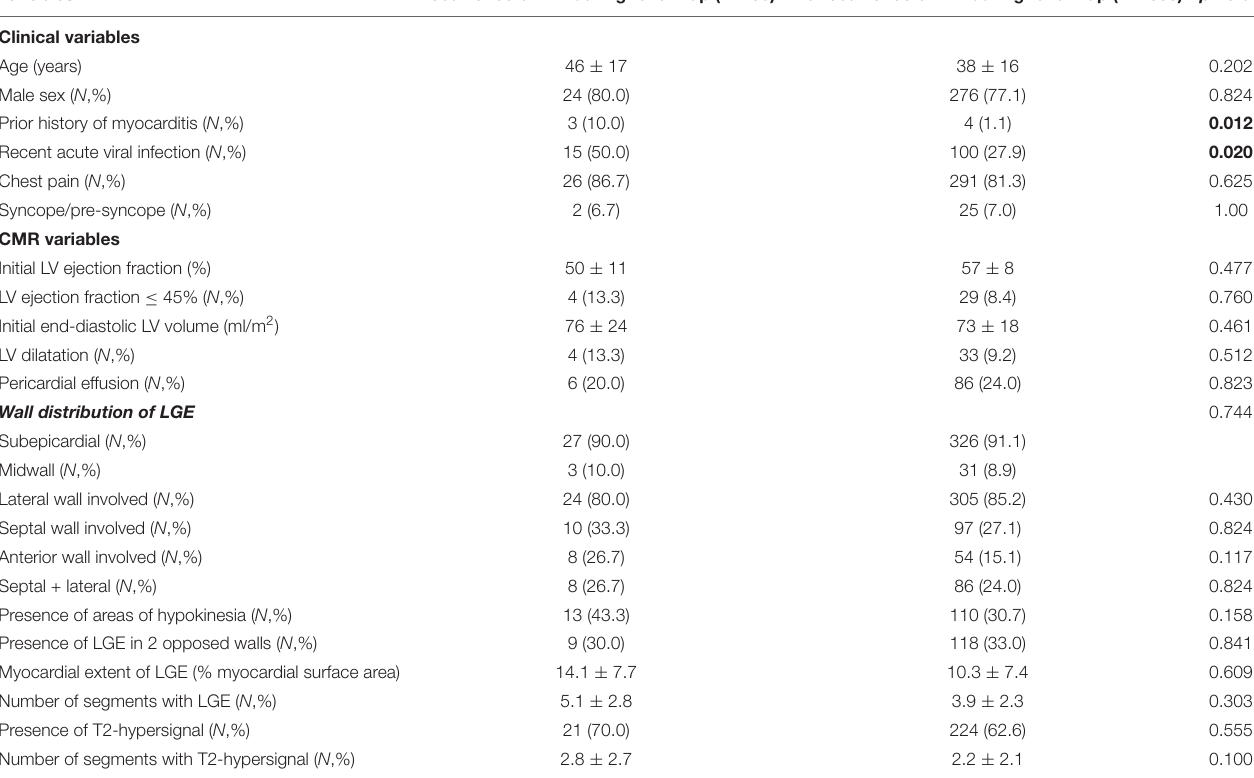
TABLE 5 | Patients with/without recurrence of AM during follow-up. Variables Clinical